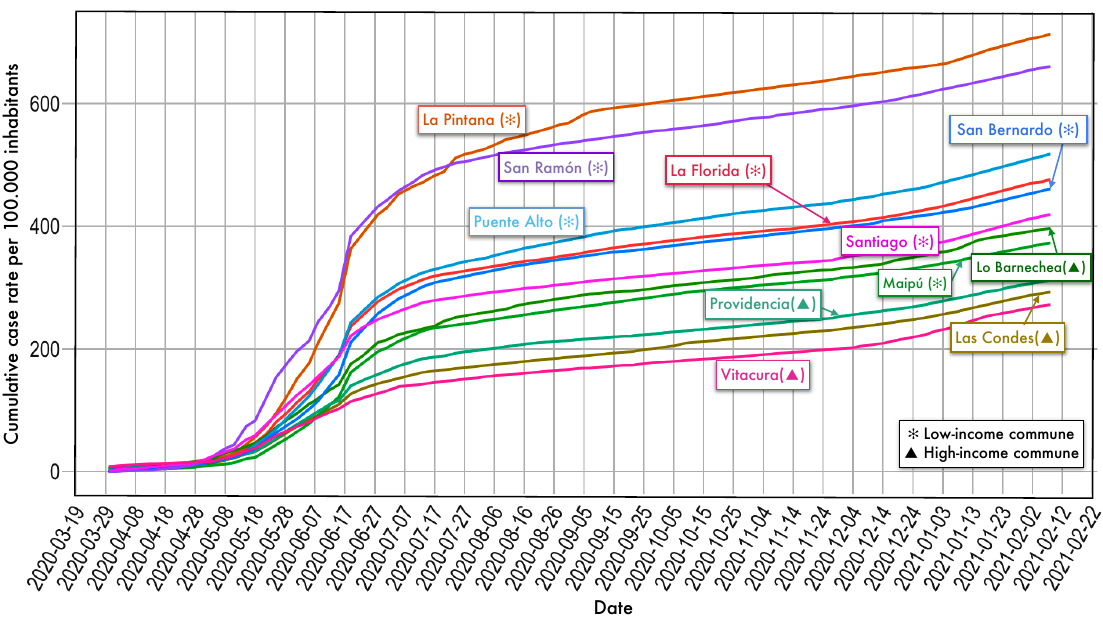
Figure 9. Cumulative cases of COVID-19 for the communes of the Metropolitan